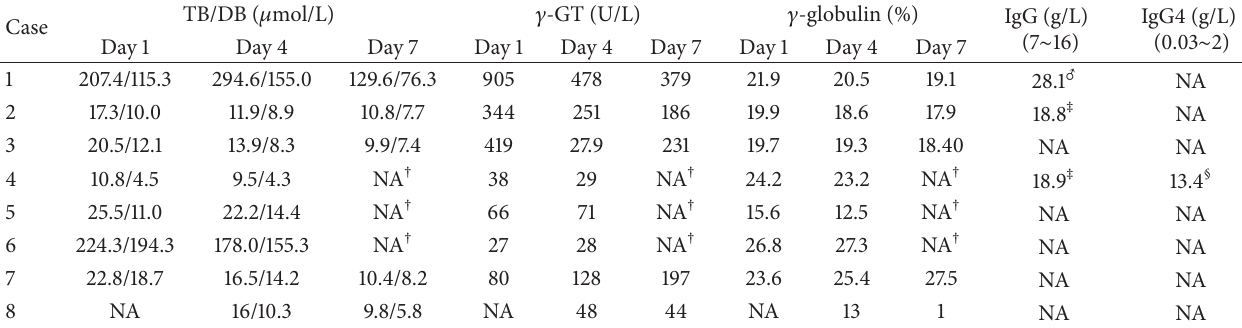
Table 3: Biochemical changes for AIP patients receiving operation in the perioperative period.